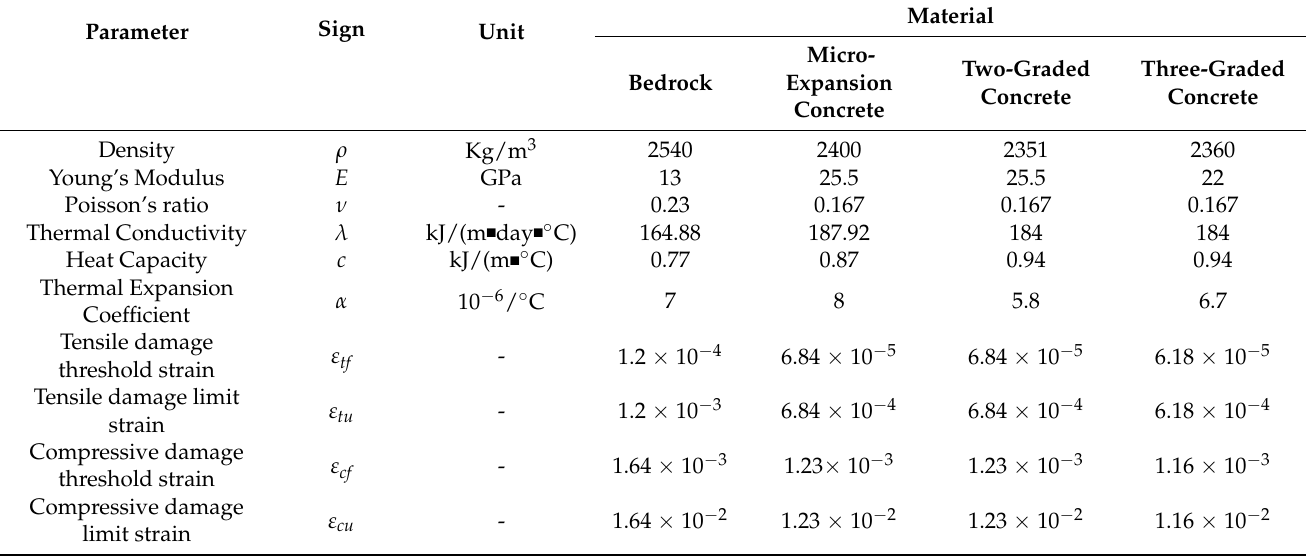
Table 5. Material parameters of the macro scale